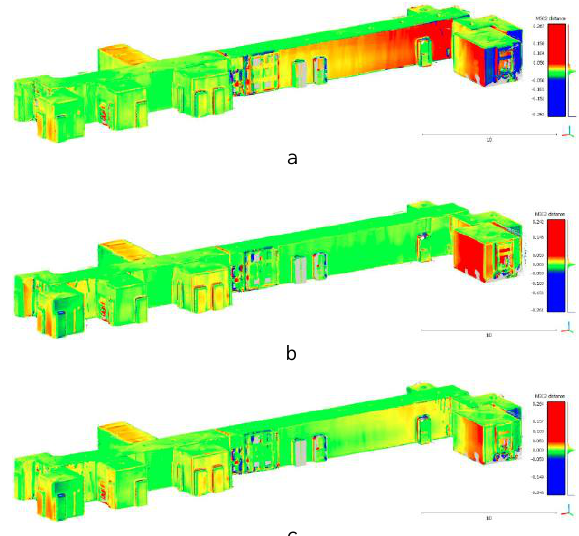
Figure 5. Cloud to cloud distances and the effect of increasing number of loops; a) one loop, b) two loops, and c) three loops.